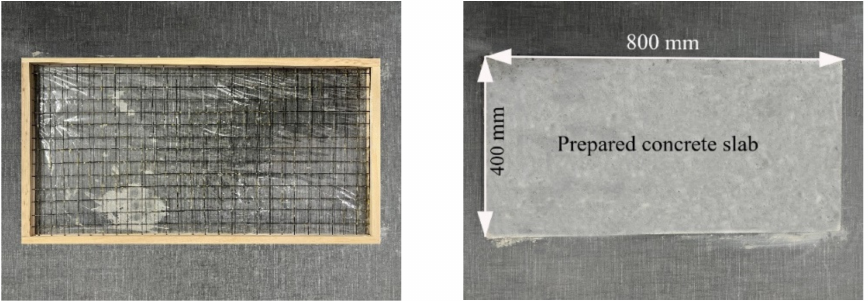
Figure 2. Wooden mold ( left ); cured concrete slab ( right ).